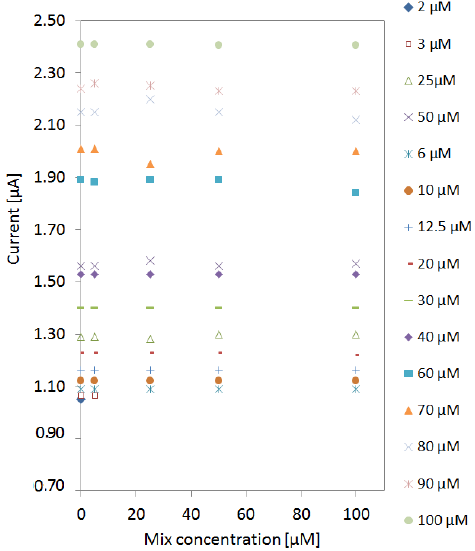
Figure 4. Detection of pyocyanin in different mix backgrounds between 5 µM and 100 µM in addition to pyocyanin detection in MilliQ water (zero mix background). The current peaks of the varying pyocyanin concentrations were unaffected by the mix concentration. Detection of 2 µM pyocyanin was only possible when no interfering signals were present. When the mix concentration was above 25 µM the detection limit of pyocyanin remained 6 µM.